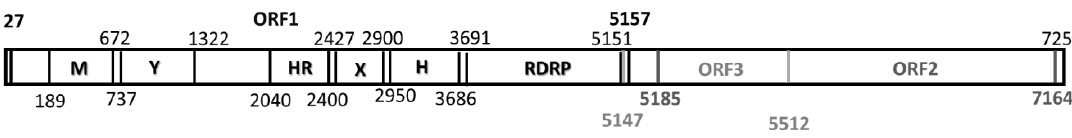
Table 2. Nucleotide and amino acid identity (%) of swine HEV isolate MXCDg3_B1c|_2016 with complete genome sequences of various genotypes retrieved from GenBank with over 75% homology.